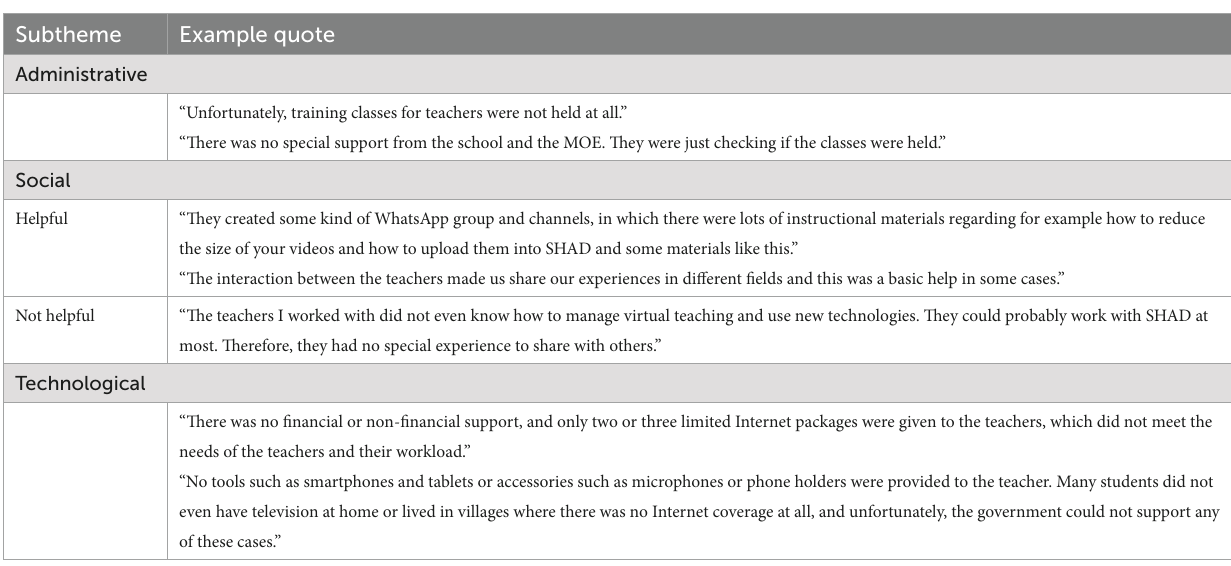
TABLE 10 Theme 3 support: Subthemes, categories, and example